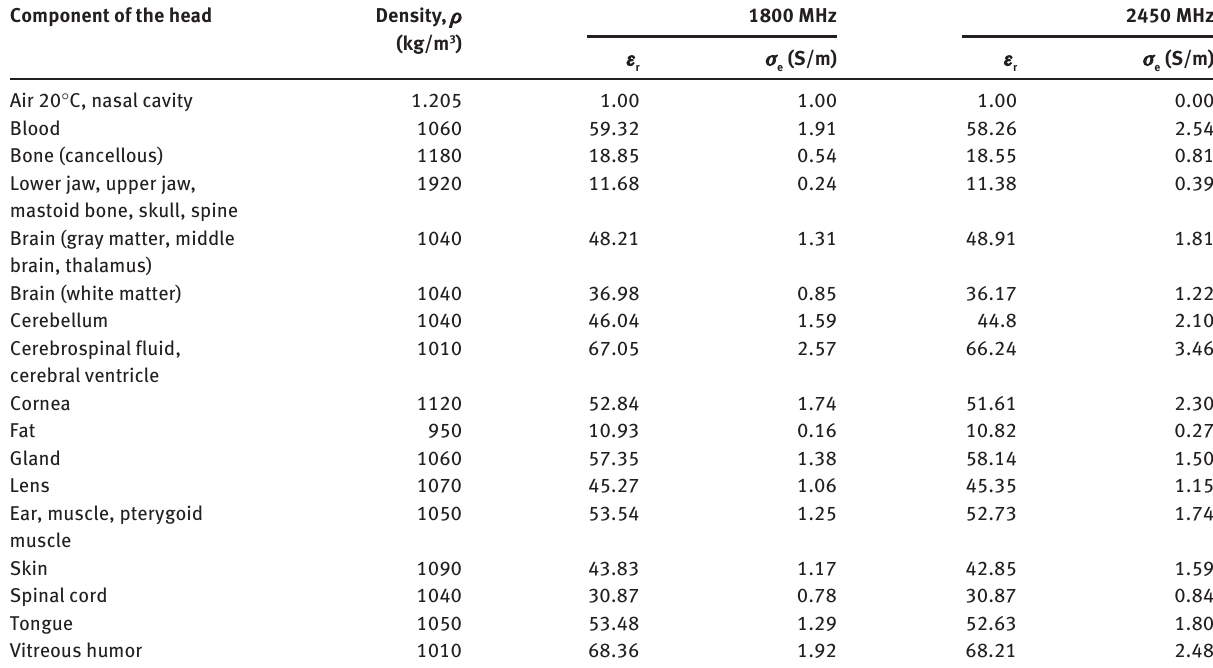
Table 1 Dielectric properties at different frequencies for human head tissues. Component of the